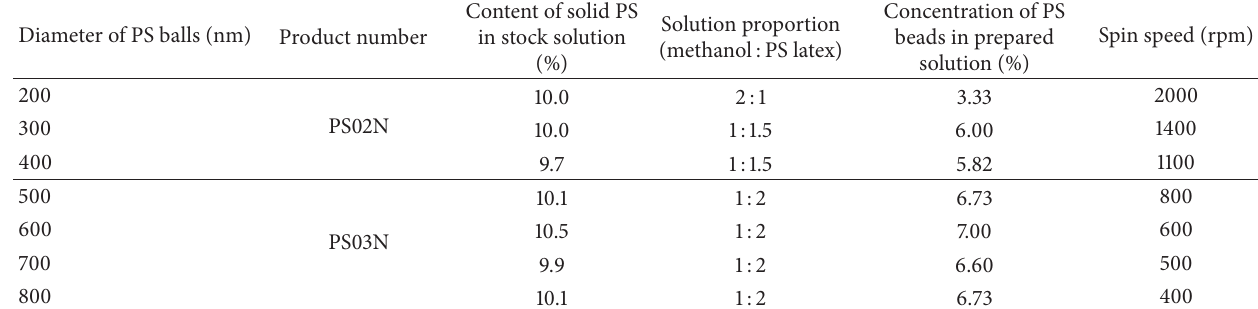
Table 1: The product information and experimental details are for the PS nanosphere with different periodicities. Diameter of PS balls (nm)